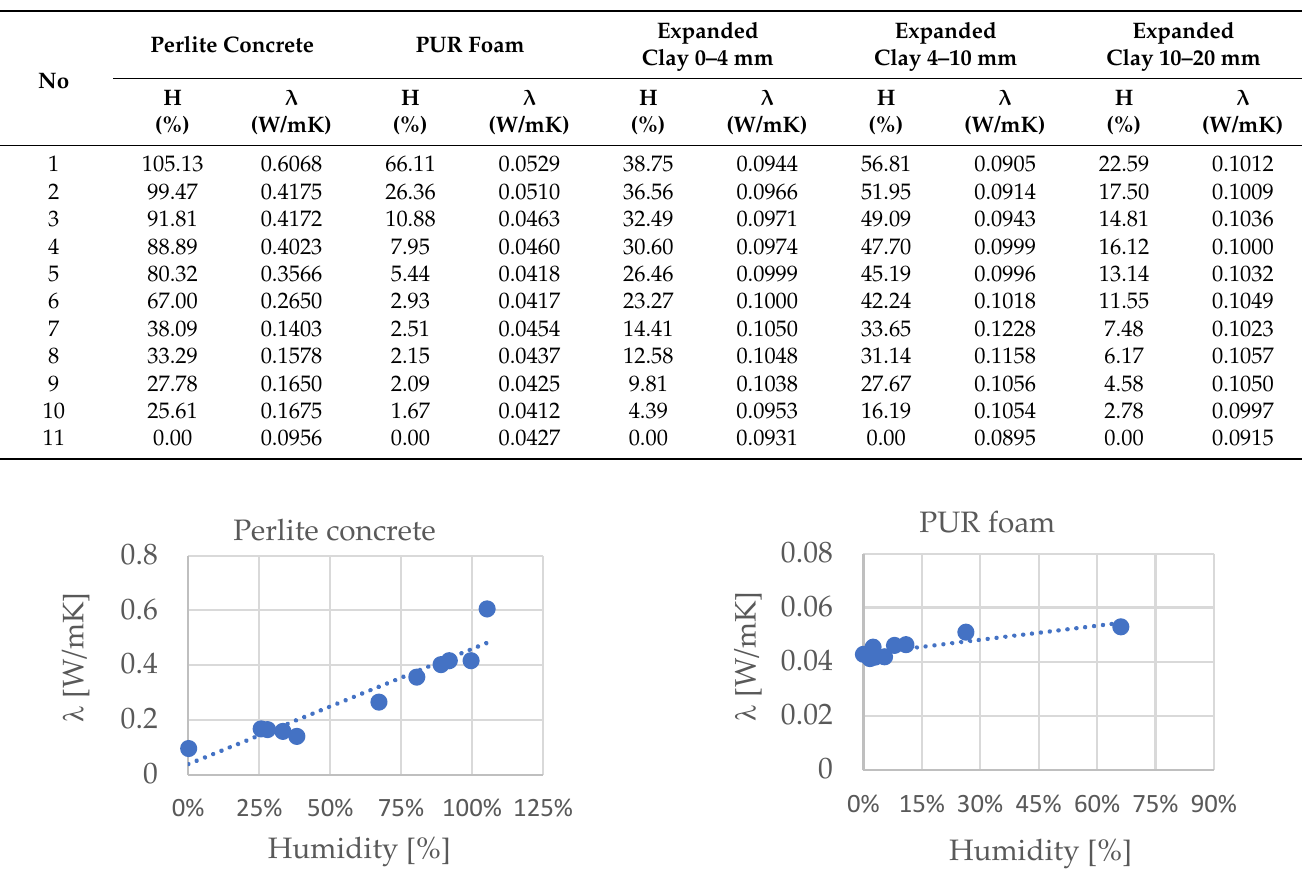
Table 1. Measurement results of the thermal conductivity λ for mass moisture content for different insulation materials. Figure 1. Testing of perlite concrete with a surface probe ( a ), testing of PUR foam with a needle probe ( b ), and testing of expanded clay with a needle probe ( c ). The measurement results for individual insulation materials are presented in Table 1 and Figures 2 and 3.